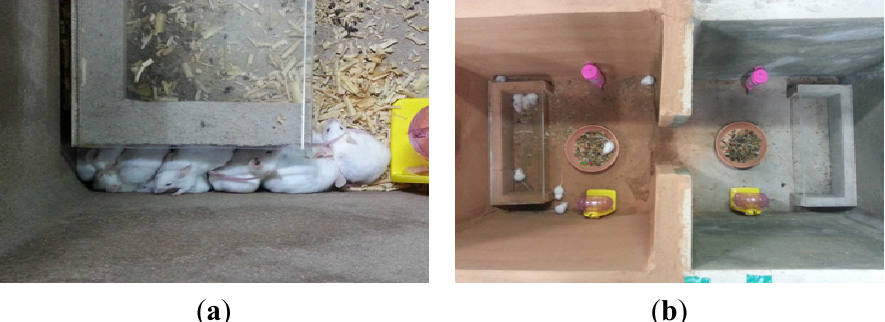
Figure 21. Residence preference. ( a ) 20% Hwangtoh residence cage and ( b ) 80% Hwangtoh residence cage.